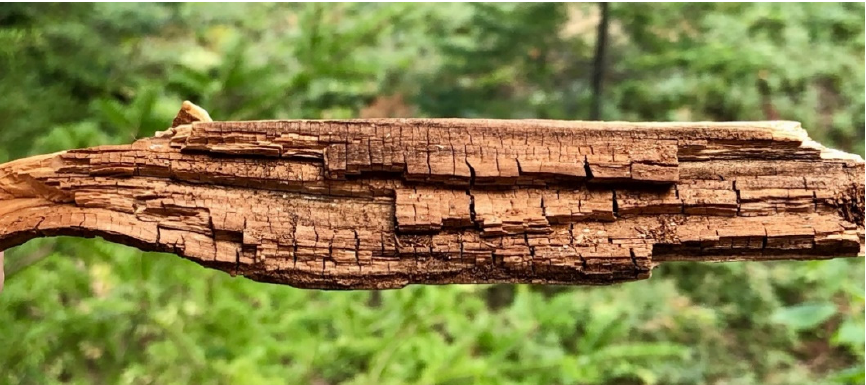
Figure 1. Classic advanced brown rot fungal decay in a softwood. Note the checks (cracks) which cut across the grain of the wood giving the wood a cubical appearance. In early stages of brown rot